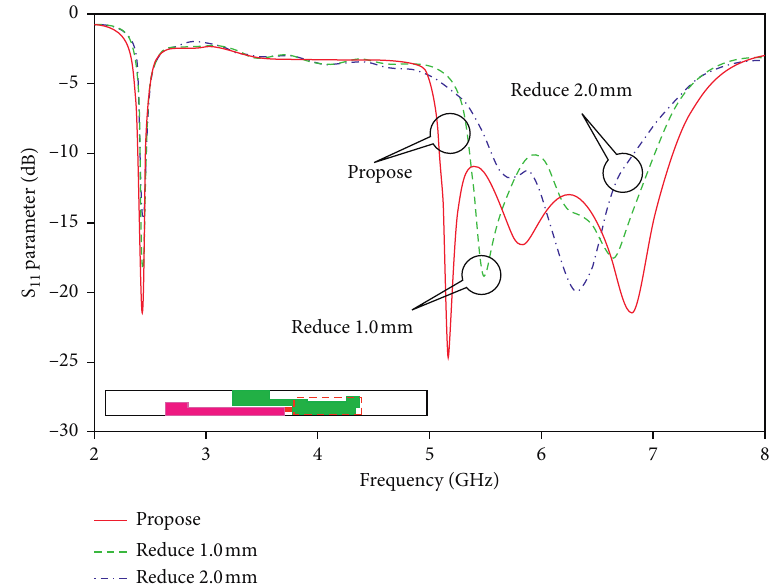
Figure 8: Simulated S 11 values with different lengths of direct-fed right arm of antenna.